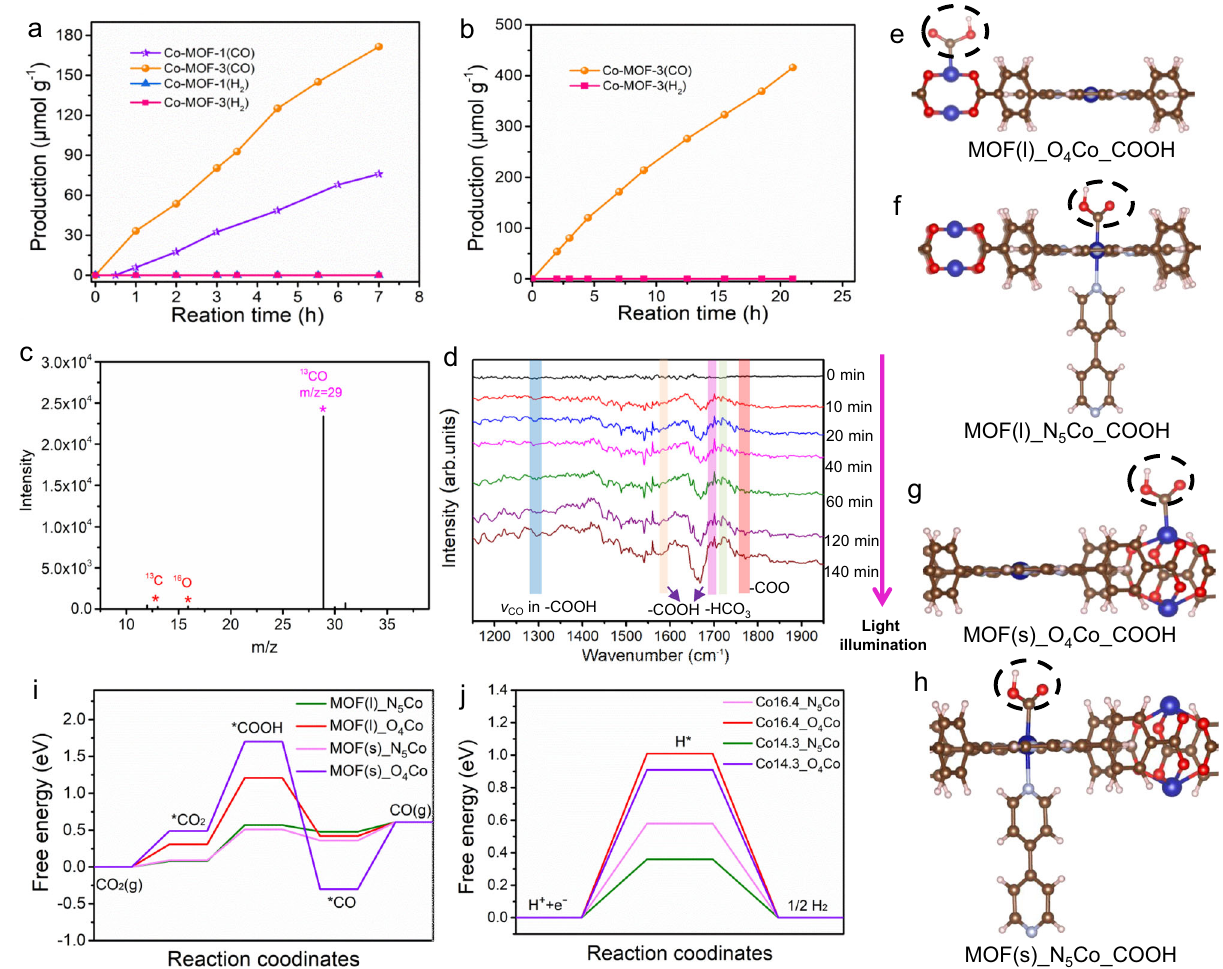
Fig. 6 Photocatalytic CO 2 reduction performance of Co-MOF-3 homojunction. a Evolution of CO and H 2 as a function of reaction time during the CO 2 reduction in aqueous solution under visible-light illumination for the Co-MOF-1 and Co-MOF-3 photocatalysts. b Stability of Co-MOF-3 during the continuous CO 2 reduction reaction. c Isotope labeling of Co-MOF-3 system carried out by using 13 CO 2 gas. d In situ DRIFTS measurement of Co-MOF-3. e – h Schematic illustration of intermediate *COOH adsorbed onto MOF(l)_N 5 Co, MOF(l)_O 4 Co, MOF(s)_N 5 Co, and MOF(s)_O 4 Co in the Co-MOF-3 homojunction during CO 2 reduction, respectively. Calculated free energy ( Δ G ) diagram of i CO 2 reduction to CO and j HER on Co sites in varied units